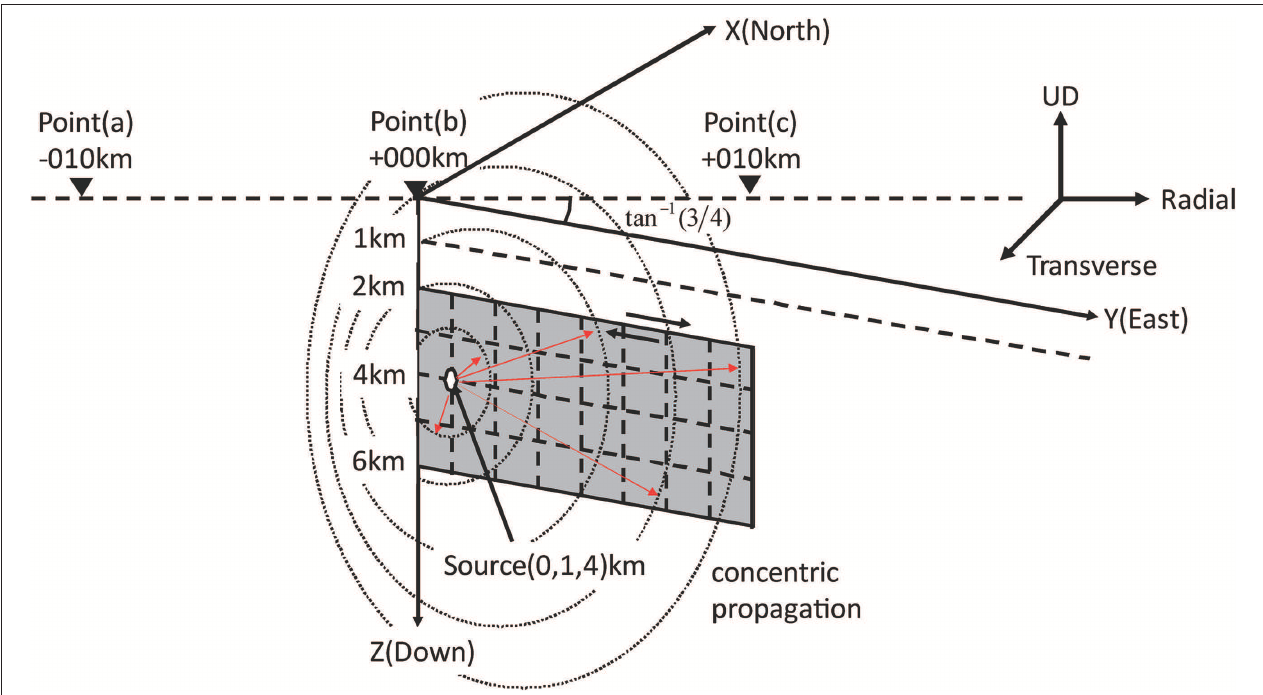
FIGURE 3 | Fault plane and three recording points (replotted based on Kato et al., 2011).